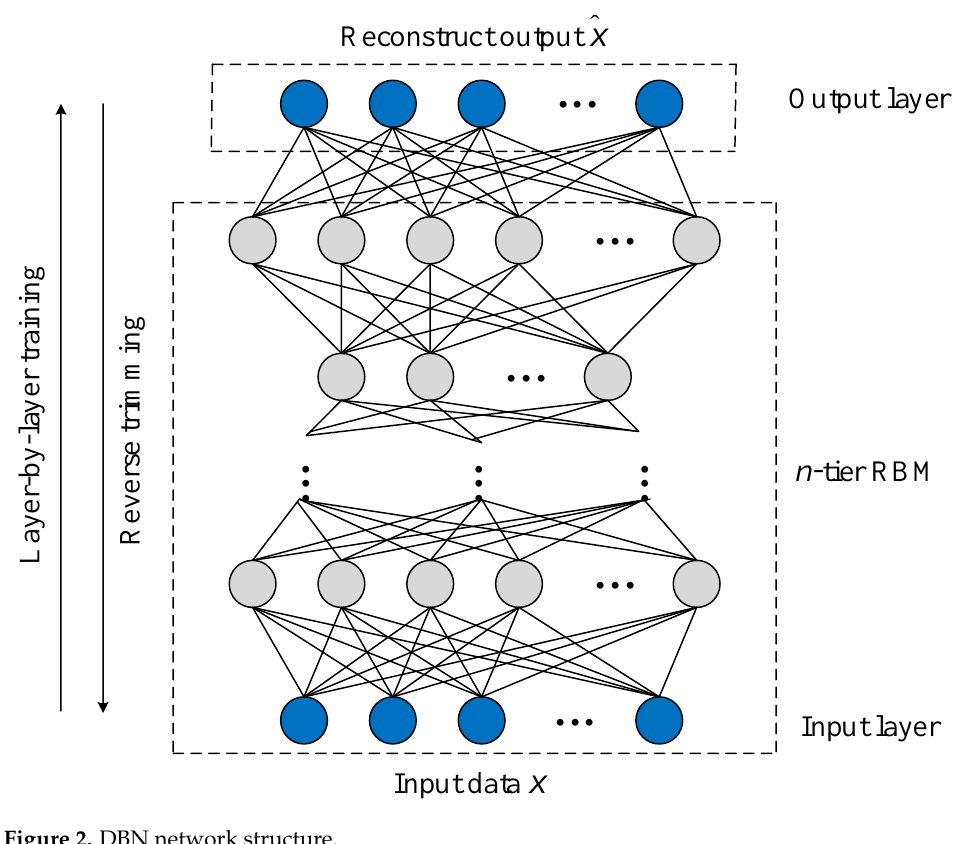
Figure 2. DBN network structure. The pre-training of the DBN model uses the CD-k algorithm to train the weights and biases of each RBM in the network layer by layer unsupervised [35]. RBM basic structure is shown in Figure 3. RBM consists of a visible layer and a hidden layer. There is no connection within the layer, and no full connection between layers [36].